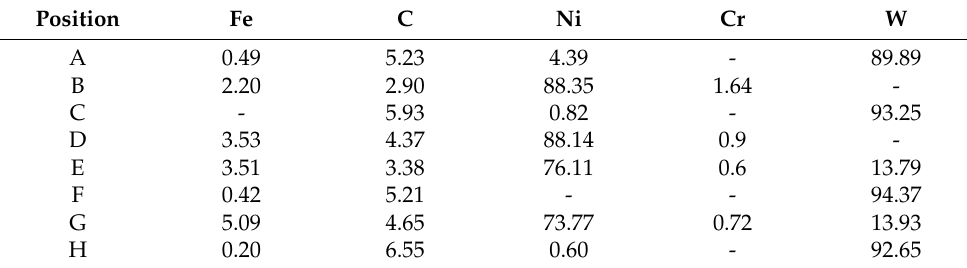
Table 2. EDS results of marker point in Figure 1 (wt%).